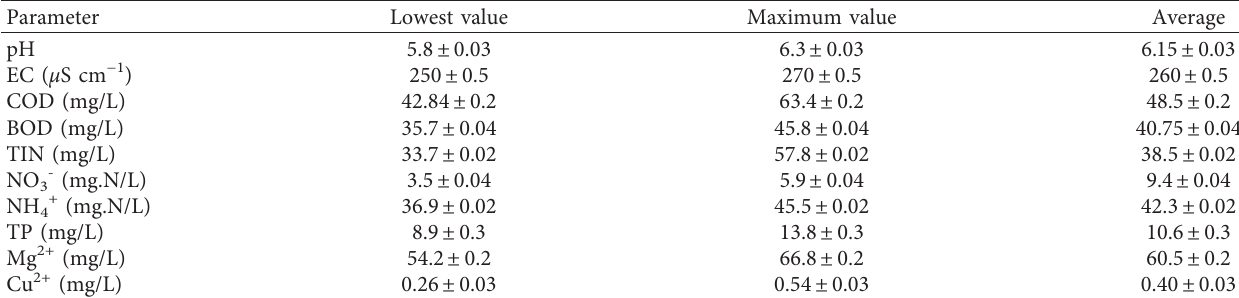
Table 1: Physicochemical properties of the SERWW used in the